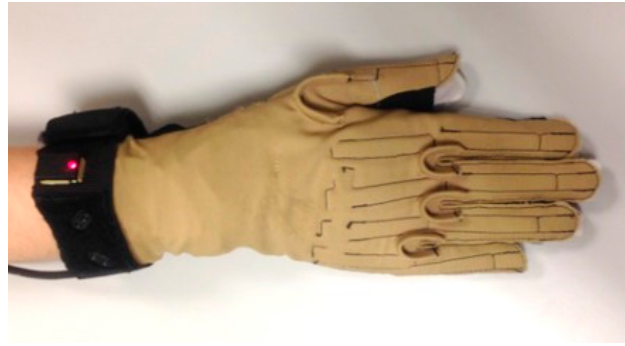
Figure 2. Reference posture considered with the instrumented glove